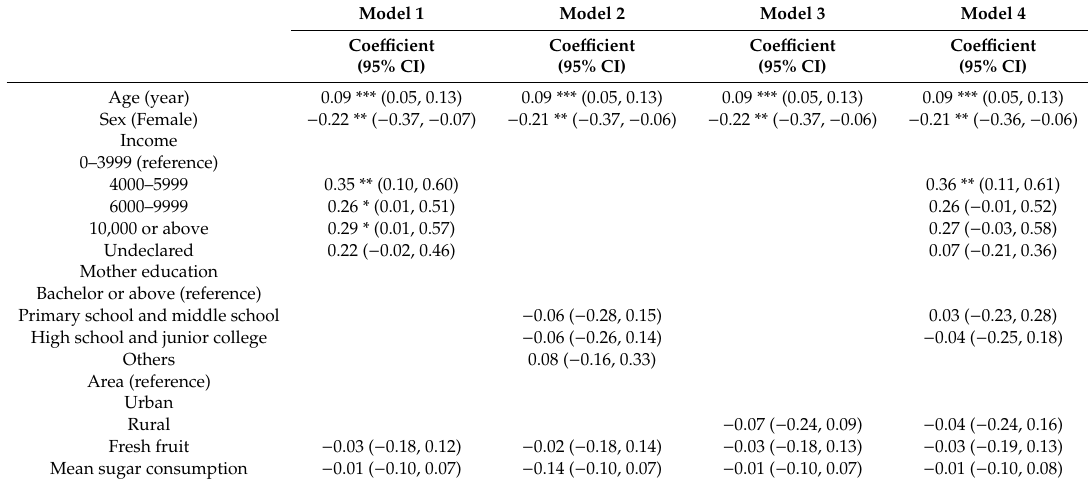
Table 3. Multilevel linear analysis of factors associated with changes in weight-for-age z-score (WAZ) over one year among 772 preschool children in China.